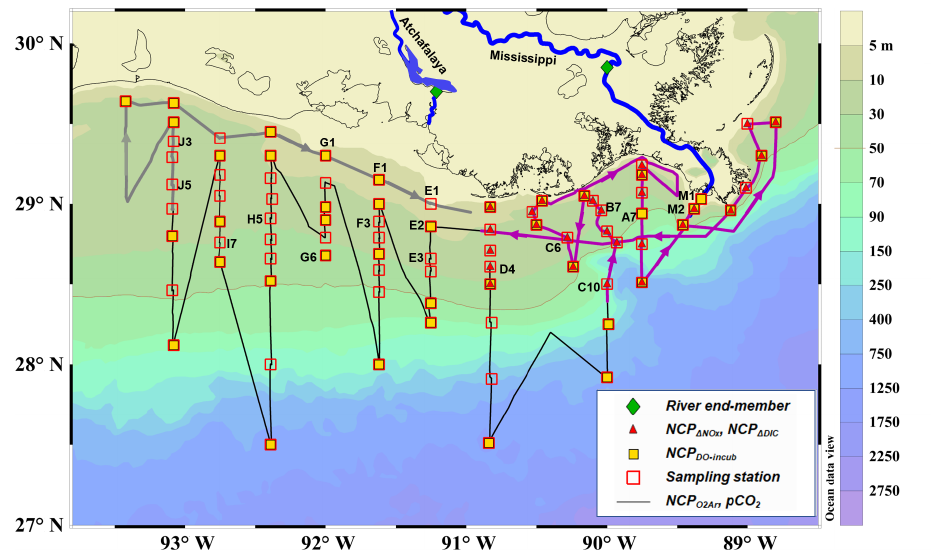
Figure 1. Map and sampling sites in the northern Gulf of Mexico during the April 2017 cruise. The black dotted line is the cruise track along which the high-resolution underway measurements were made. The tracks in the Mississippi plume (purple line, 8–11 April) and in the Atchafalaya coastal regions (grey line, 15–17 April) are highlighted. Also shown are the 83 CTD sampling stations (hollow red squares), the 43 stations where light/dark bottle DO incubations were conducted (solid yellow squares), the 30 stations where non-conservative changes in DIC and NO x were used to estimate NCP rates (solid red triangles), and the 2 stations where the properties of river end-members were measured (solid green diamonds). The vertical CTD profiles of the labeled stations are shown in the Supplement. Figure generated by Ocean Data View (Schlitzer,